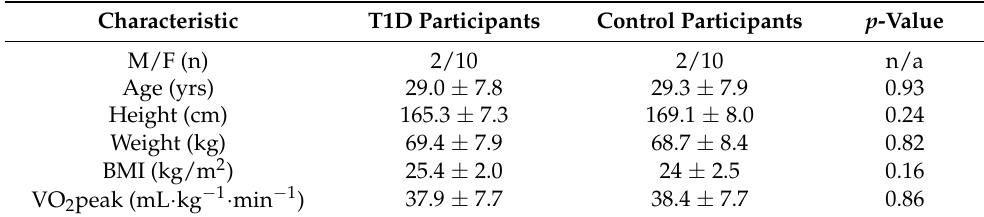
Table 1. Participant characteristics presented as mean ±